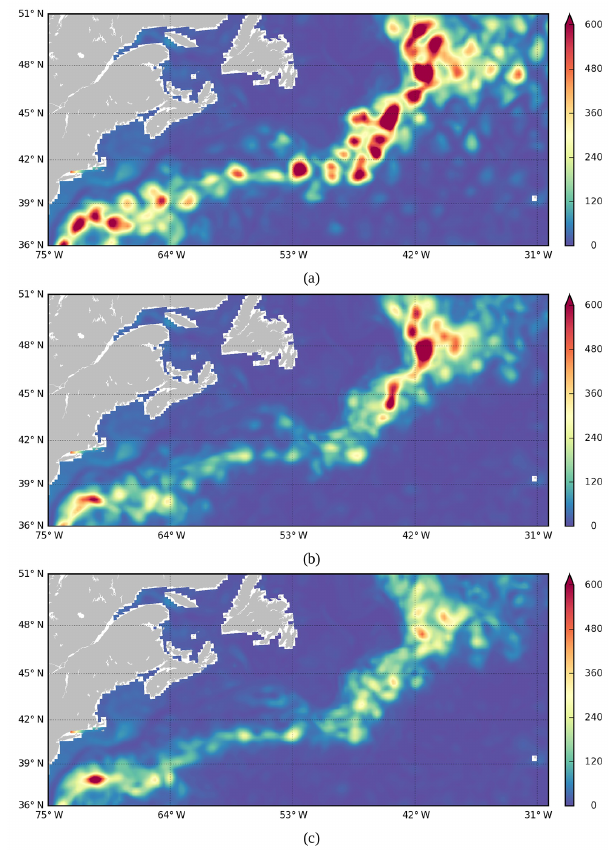
Figure 5. GS analyses MSE of SL in cm 2 for Sat1 (a) , Sat2 (b) and Sat3 (c)